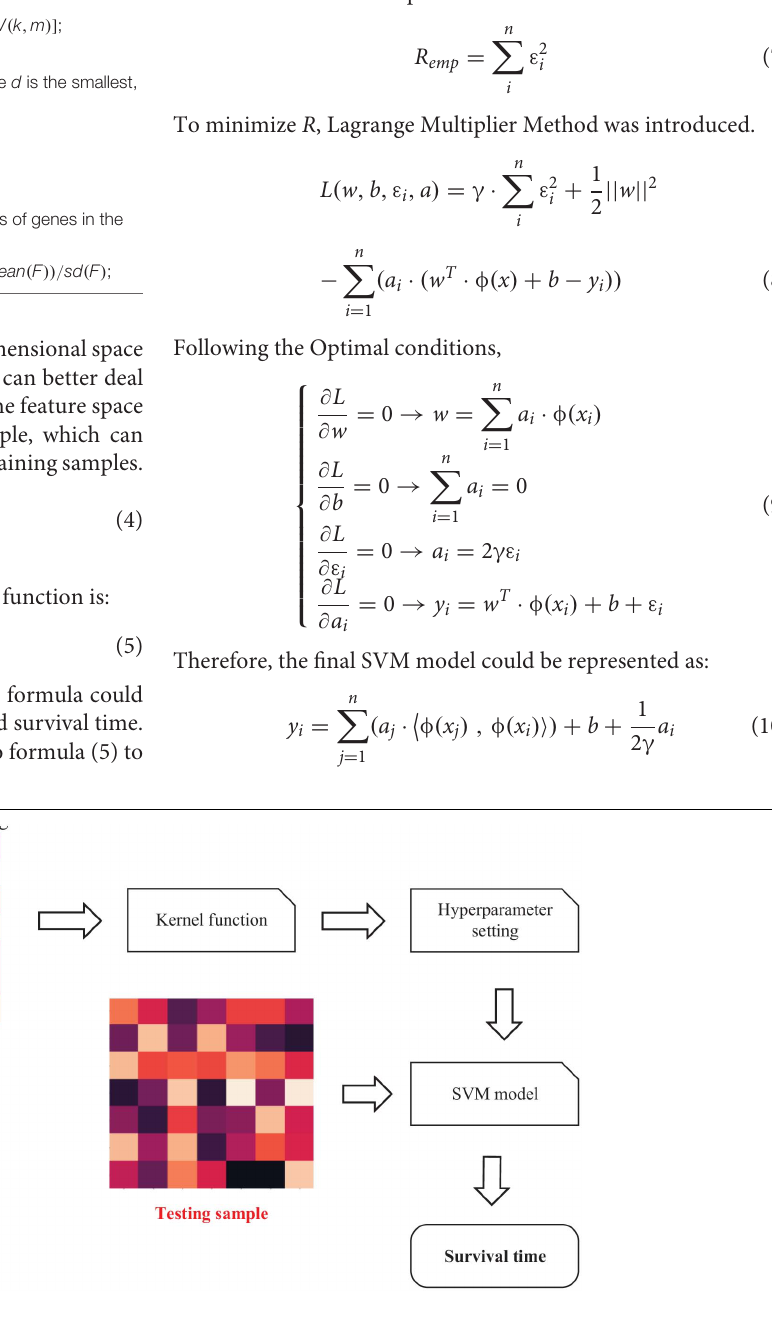
FIGURE 4 | Workflow of Support Vector Machine (SVM)-based prediction method.